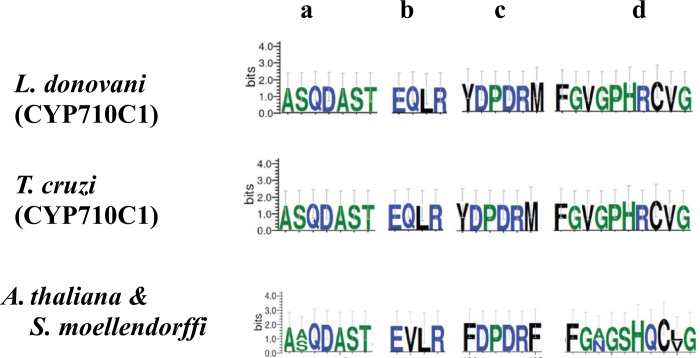
Sequence logos of the conserved CYP motifs of Leishmania and their comparison with Trypanosoma cruzi, Arabidopsis thaliana and Selaginella moellendorffii.The most characteristic motif FXXGXRXCXG (d) corresponds to the heme-binding domain. The second conserved motif EXLR (b) and the third consensus PER (c) form E–R–R triad and are essential for stabilization of the core structure. AGXDTT (a) is known to contribute to oxygen binding and activation.